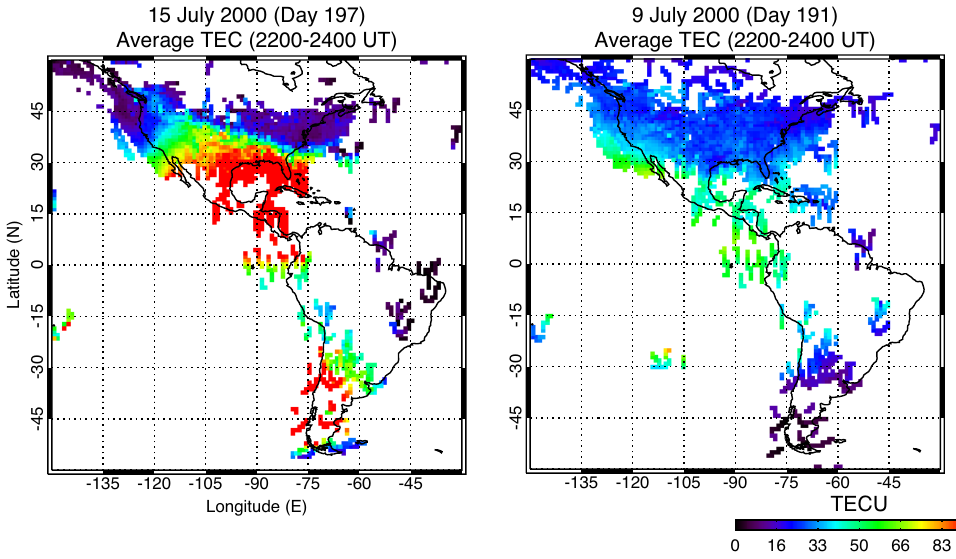
Fig. 1. GPS map of total electron content on the storm day 197 (left panel) and on a more usual quiet day 191 (right panel) of year 2000. Maps are constructed over the American continent in the period 22:00–24:00UT. The geographic latitude and longitude are shown on each